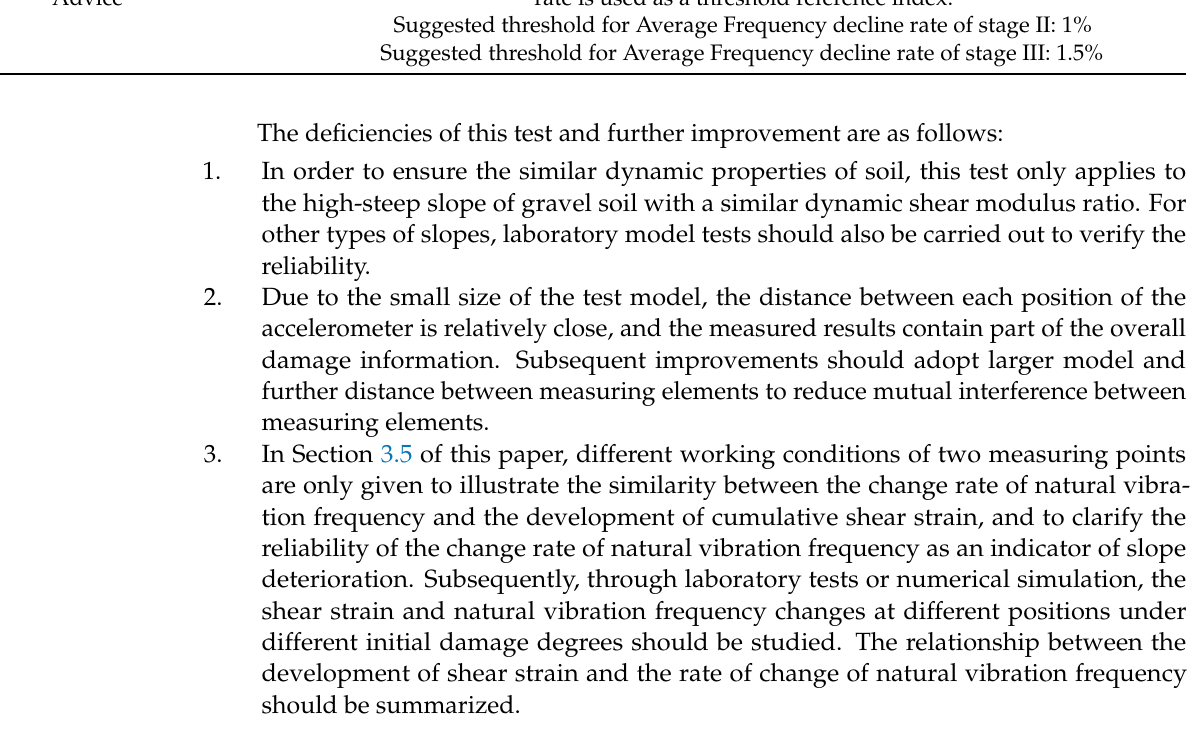
Advice Suggested threshold for Average Frequency decline rate of stage II: